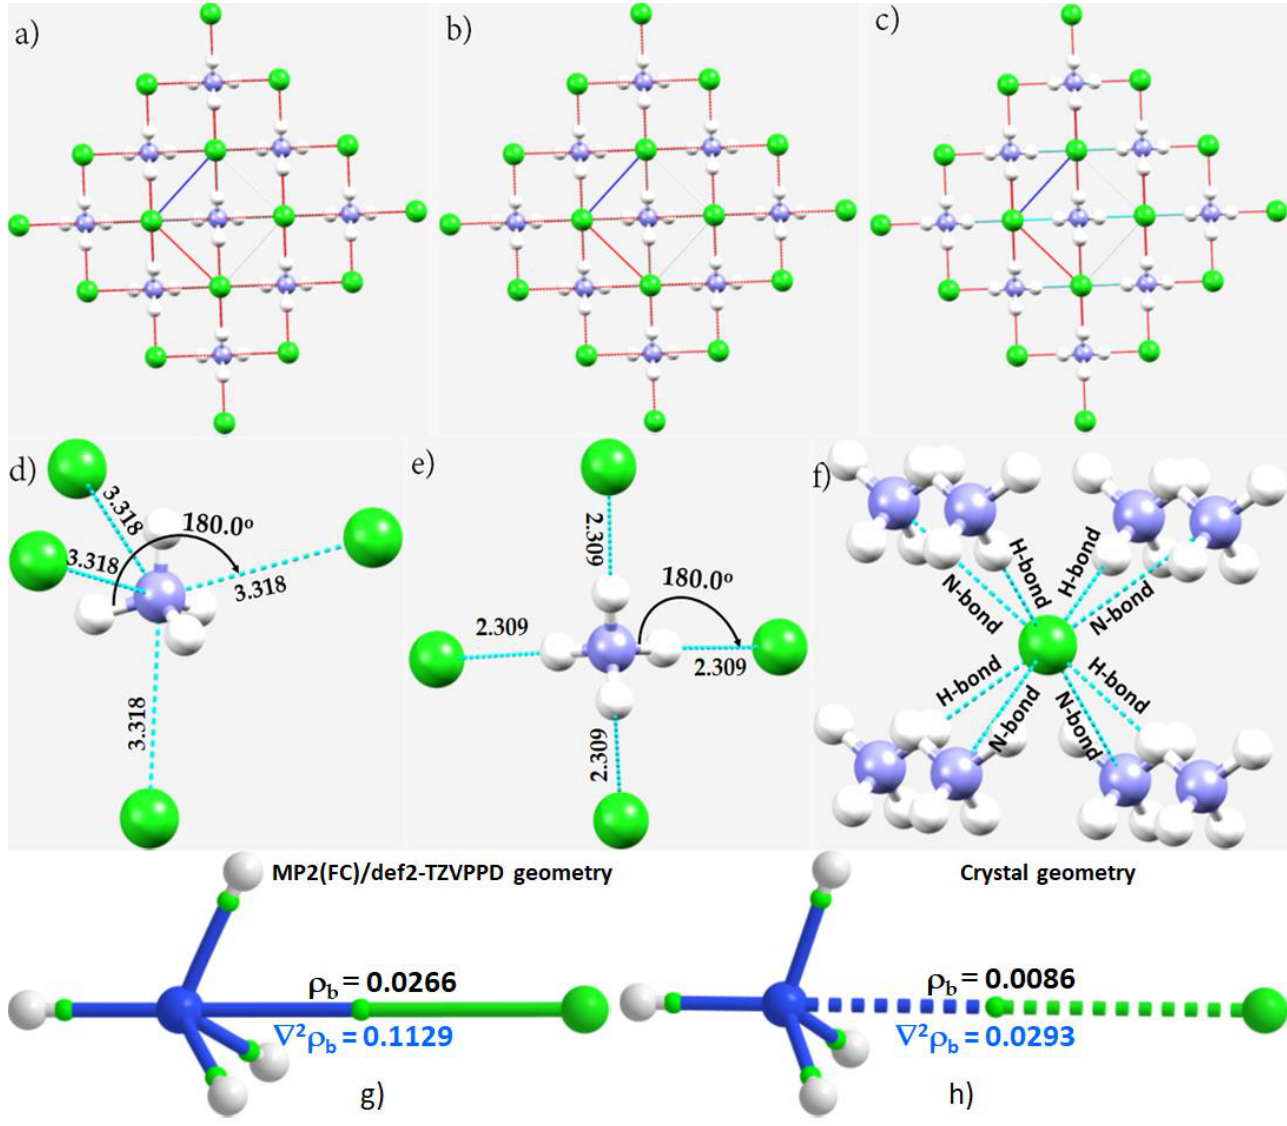
Figure 9. Three views of the crystal of NH 4 Cl (ICSD ref. 428519 [99]) showing ( a ) combined H ··· Cl hydrogen bonds and N ··· Cl pnictogen bonds, ( b ) N ··· Cl pnictogen bonds, and ( c ) H ··· Cl hydrogen bonds. Illustration of the local nature of multi-furcated charge-assisted intermolecular bonding topologies: ( d ) NH 4+ as four pnictogen bond donors; ( e ) NH 4+ as four H bond donors; and ( f ) Cl − as four H-bond and four N-bond acceptors. Bond lengths and bond angles are in Å and degrees, respectively. The dotted lines in cyan/red represent inter-ionic interactions. ( g , h ) MP2(FC)/def2-TZVPPD level QTAIM-based molecular graph for the ion-pair NH 4 Cl, obtained on its MP2(FC)/def2-TZVPPD gas-phase geometry and as in the crystal, respectively; both these graphs show bond paths as sticks and dotted lines in atom color (N—blue; Cl—green; H—white grey), bond critical points as tiny spheres between atomic basins in green, and values (in a.u. ) of charge density ρ b and the Laplacian of the charge density ∇ 2 ρ b at the N ··· Cl bond critical